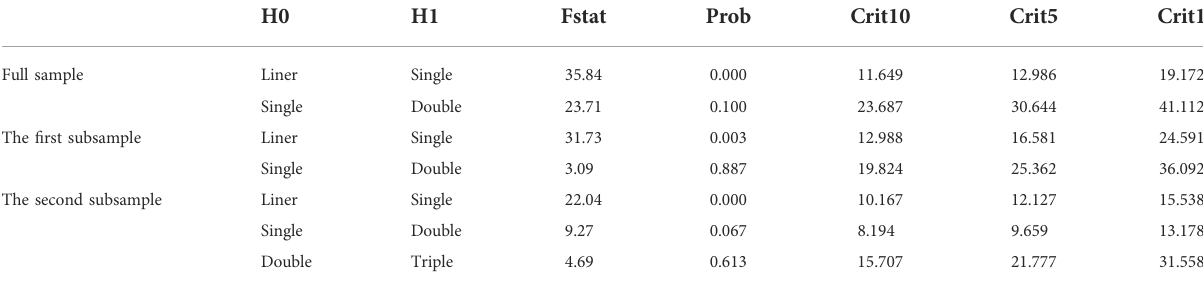
TABLE 8 Robustness check Ⅰ : Threshold effect test of investor sentiment considering quarterly precipitation difference.